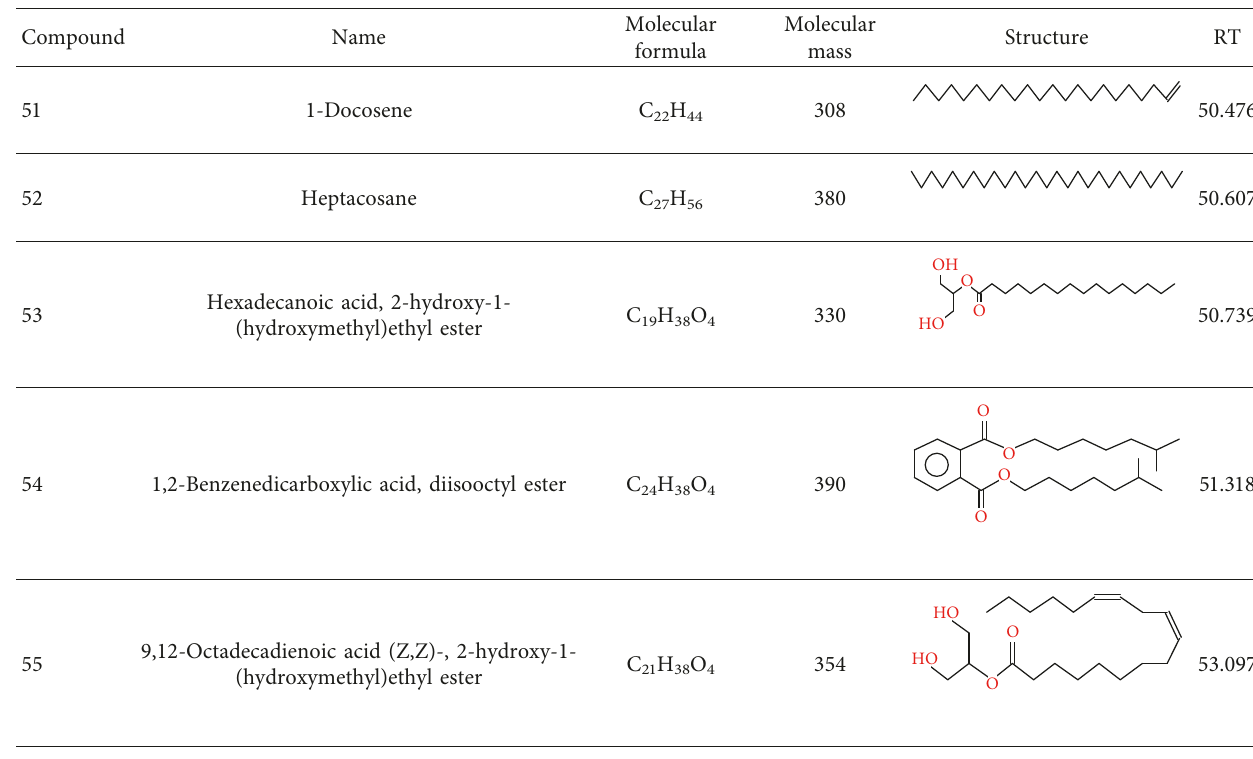
Table 12: Molecular formula, molecular mass, structure, and RT of compounds 51–55 of whole plant n -hexane fraction of Achillea wilhelmsii